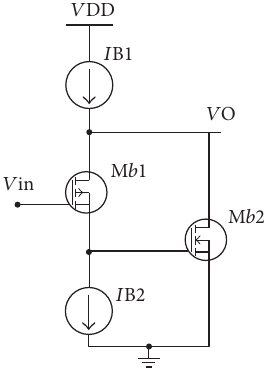
Figure 3: Circuit diagram for the